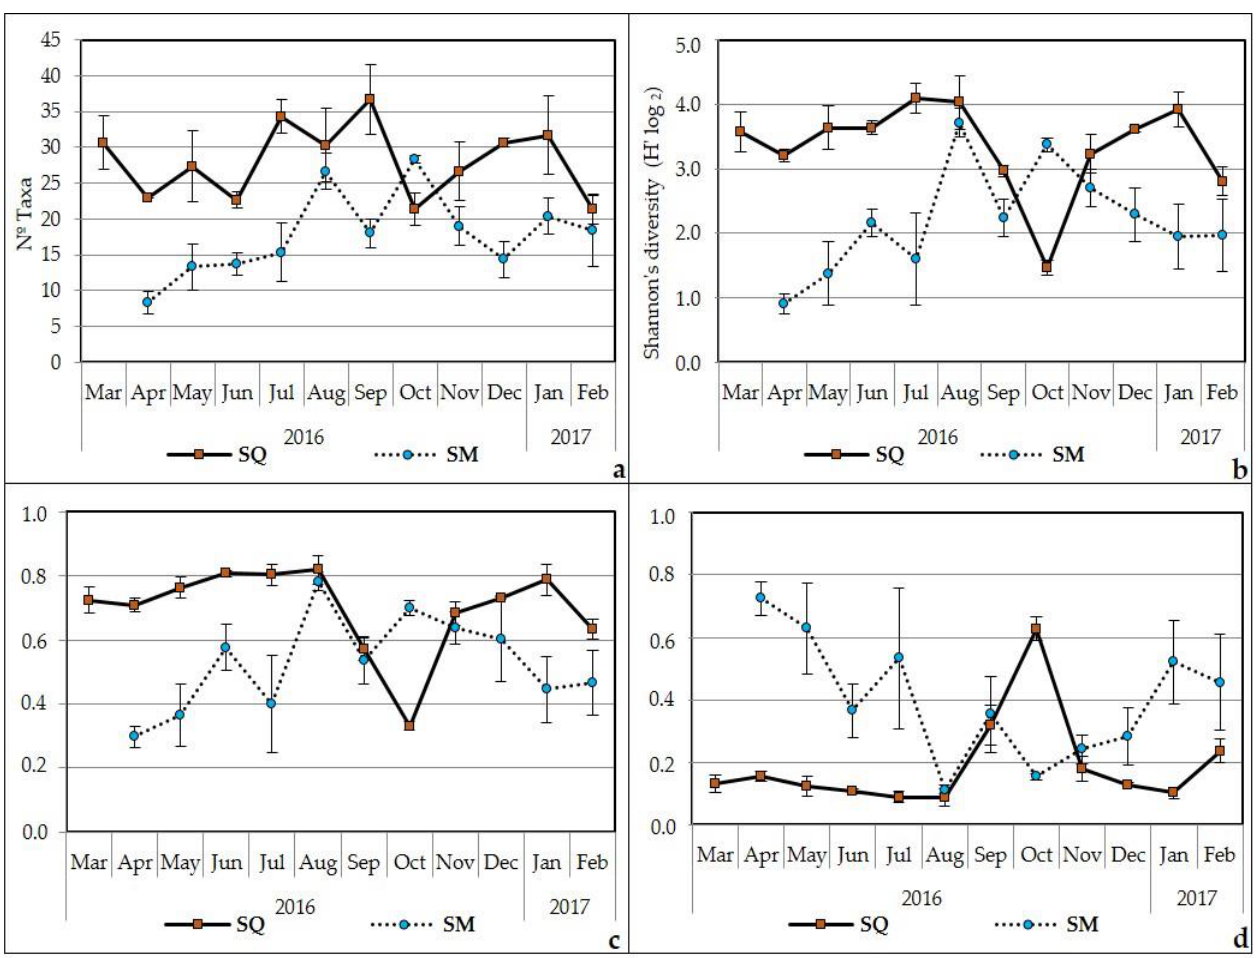
Figure 6. Monthly variability in richness ( a ), diversity ( b ), equitability ( c ) and dominance ( d ) for the epiphytic diatom community of the Saco da Quitéria (SQ) and Saco da Mangueira (SM) during the study period.